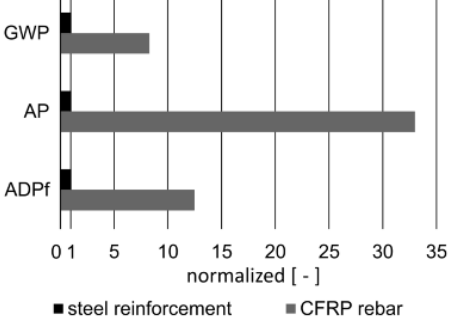
Figure 7. Comparison of steel and CFRP reinforce- ment per MPa tensile respectively yield strength as well as per density unit (normalized